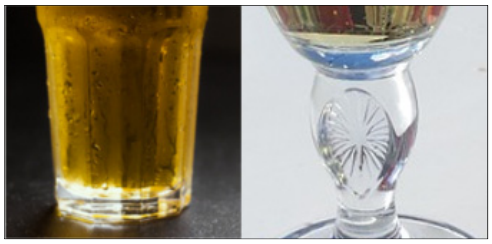
Figure 4. Two commercial examples of glassware using angularity. Angular ‐ sided Hoegaarden glass, and angularity on stem of Stella Artois chalice, detail from [59].